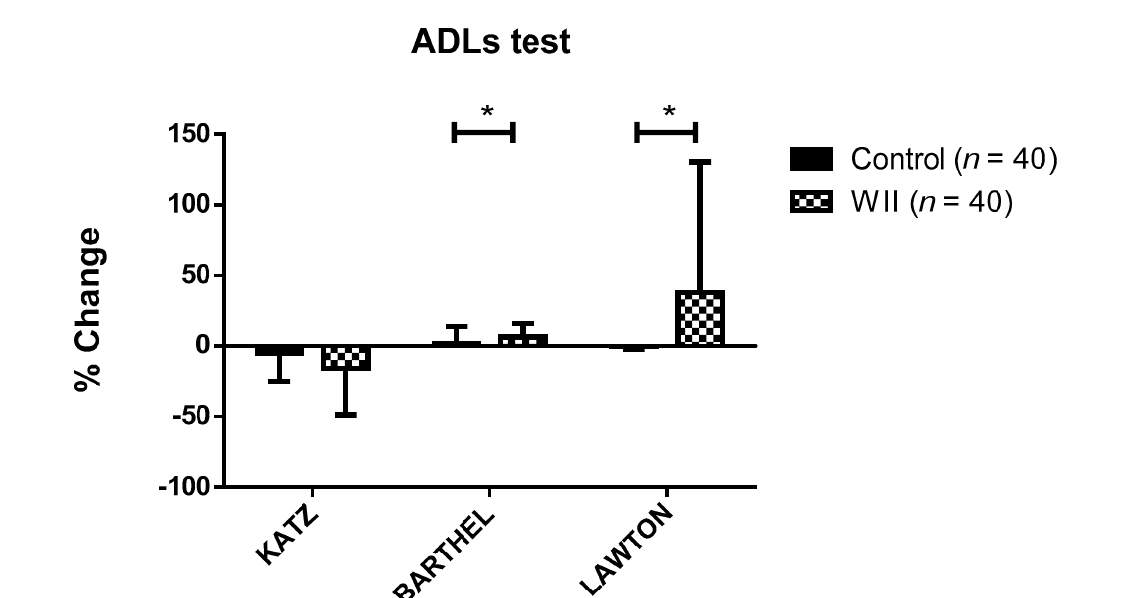
Figure 1. Change percentage during the study in both groups on the ADL test variables. Data are expressed as the mean ± standard deviation (SD). * Significant differences between groups ( p < 0.001). Table 3. Cognitive data of the control group and Wii group before and after the